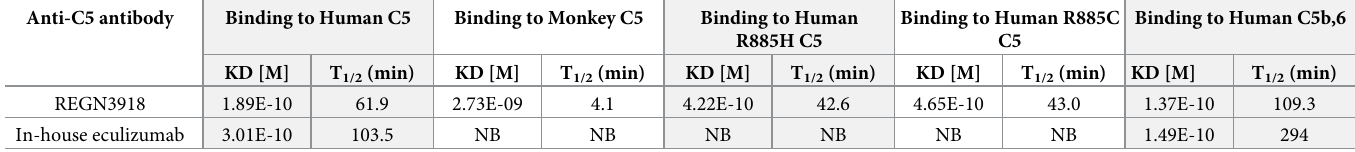
Table 2. Comparison of kinetic properties for REGN3918 and in-house eculizumab binding to human and cynomolgus monkey C5, C5 variants and C5a/6 com- plexes at 25˚C, pH7.4. Anti-C5